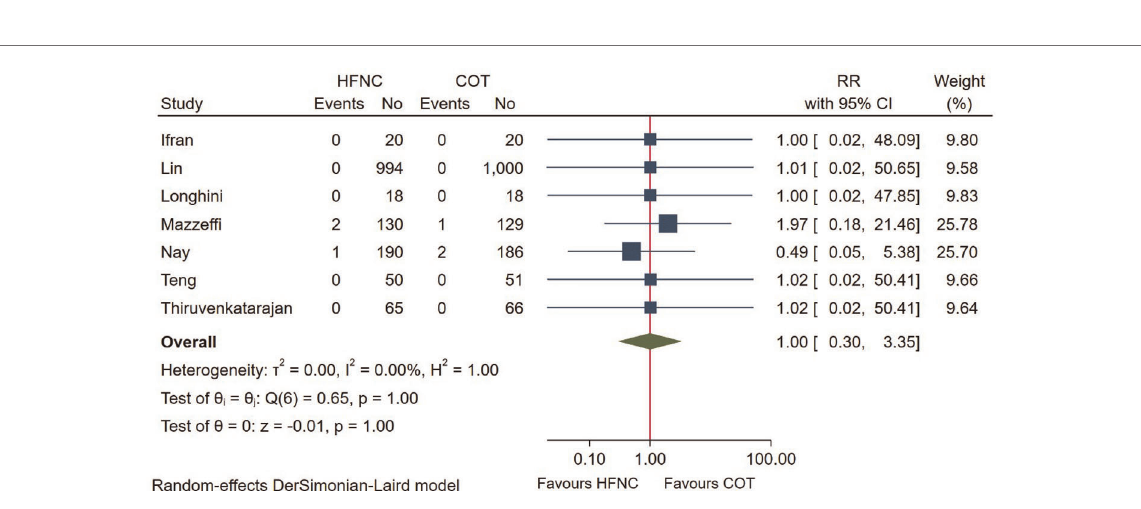
Figure S2 . In addition, after removing the trial conducted by Lin et al. (16), no signi fi cant difference was found in terms of